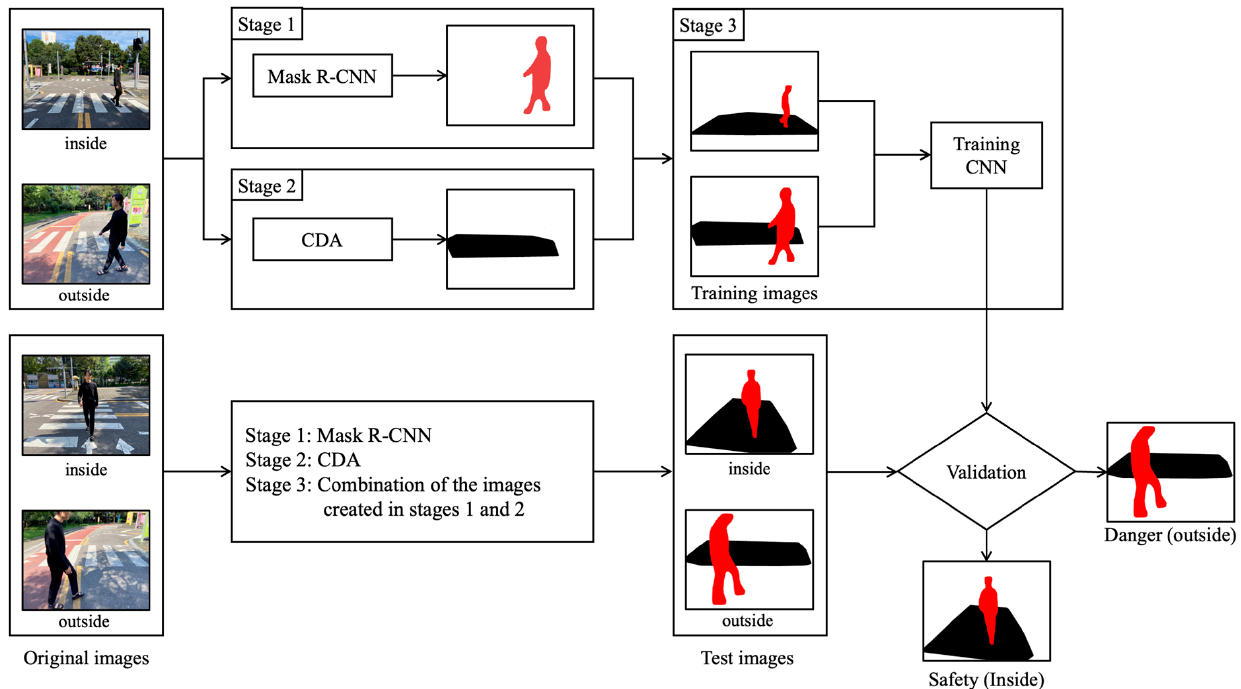
Figure 1. Overall process: CNN-based crosswalk-pedestrian situation recognition system using